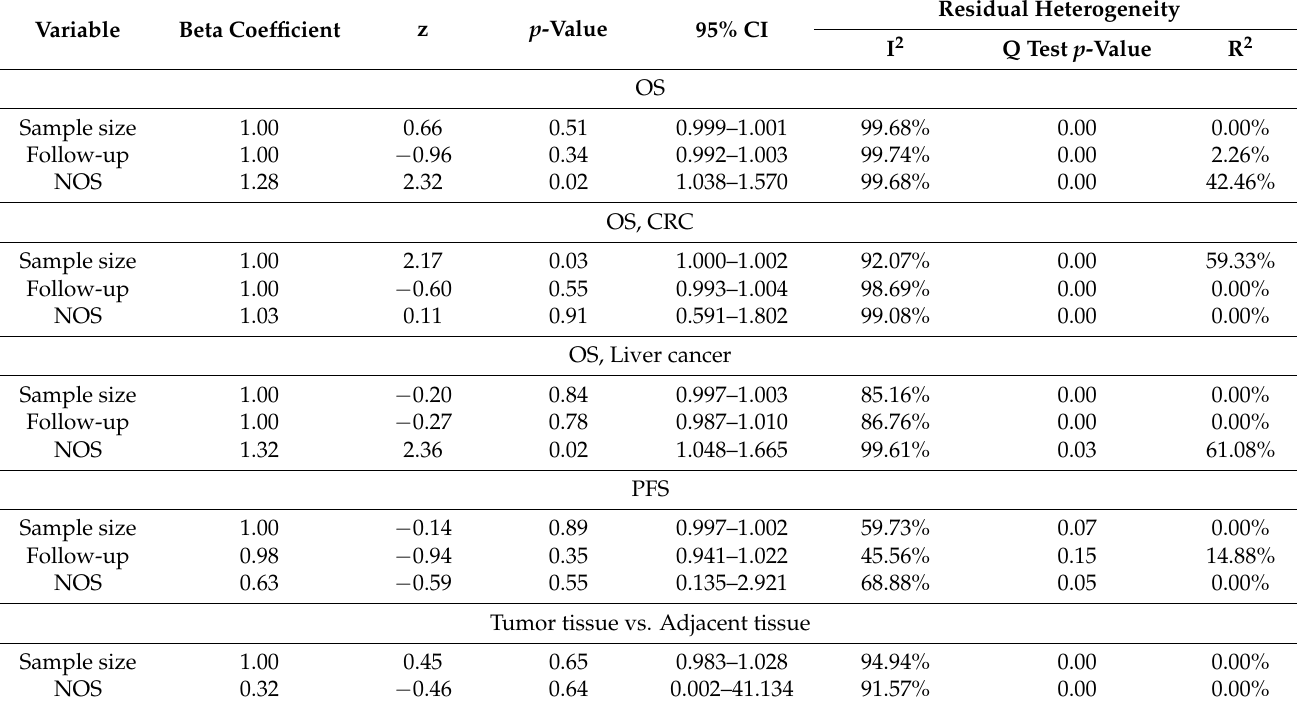
Table 2. Assessment of heterogeneity by meta-regression in global OS, CRC and liver cancer OS, PFS and tumor